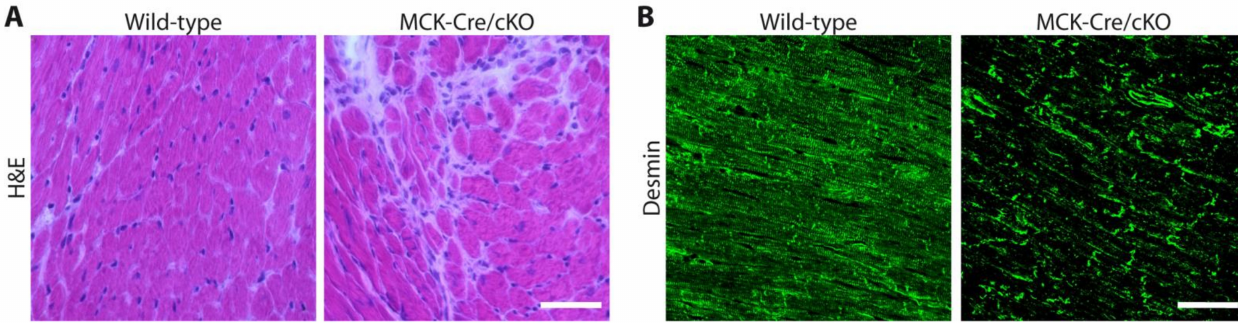
Figure 5. Heart sections from wild-type and MCK-Cre/cKO mice were stained with H&E ( A ) or subjected to immunoflu- orescence microscopy using anti-desmin antibodies (in green) ( B ). Note the increased connective tissue formation in H&E-stained MCK-Cre/cKO sections, which is indicative of cardiomyocyte degeneration. Additionally, note the focal disruption of the contractile apparatus and the desmin aggregation in the MCK-Cre/cKO cardiomyocytes. Scale bars: 50 µ M ( A ) and ( B